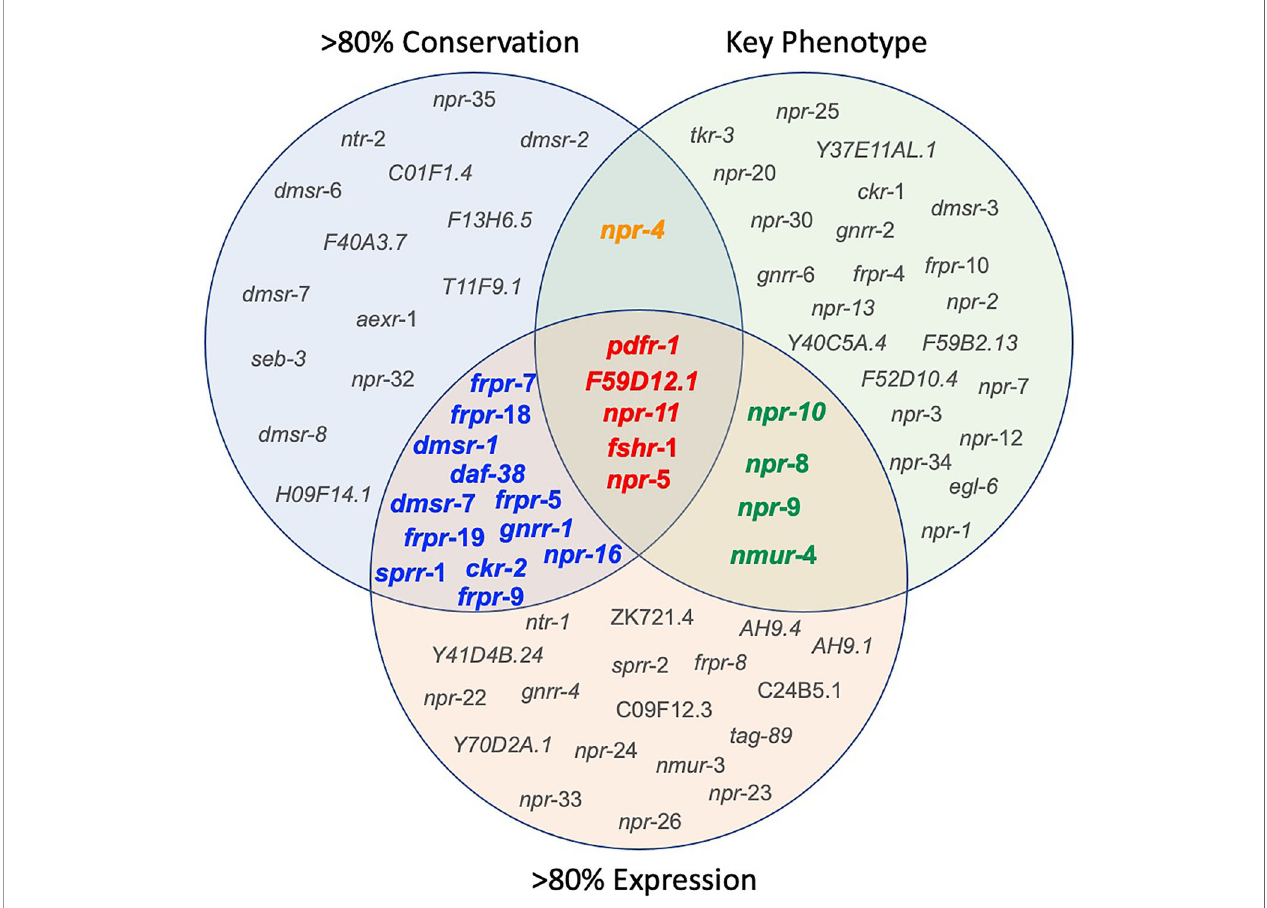
FIGURE 4 | Integration of nematode ‘ omics data informs NP-GPCR target prioritization. Venn Diagram illustrating the NP-GPCRs emerging from the prioritization pipeline following consideration of NP-GPCR conservation, NP-GPCR expression in key therapeutically relevant parasitic nematode lifecycle stages, and Ce-NP-GPCR null mutant/RNAi phenotype. Based on currently available data, the most appealing broad-spectrum NP-GPCR targets are highlighted in red. Receptors highlighted in orange represents those that share broad spectrum and key phenotype (lethality and locomotory) appeal; those highlighted in blue share broad spectrum conservation and expression attributes, and those highlighted in green share key phenotype and broad spectrum expression. >80% expression = NP-GPCRs that are expressed (FPKM>1) in more than 80% of the therapeutically relevant lifecycle stages